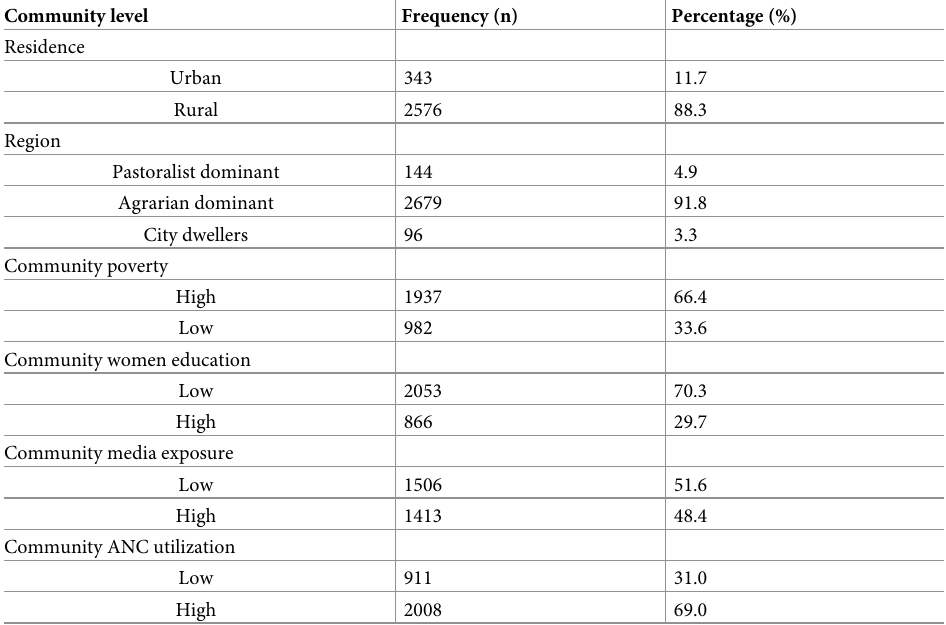
Table 3. The Community level characteristics of 6–23 months age children in Ethiopian, EDHS 2016 (n = 2919). Community level